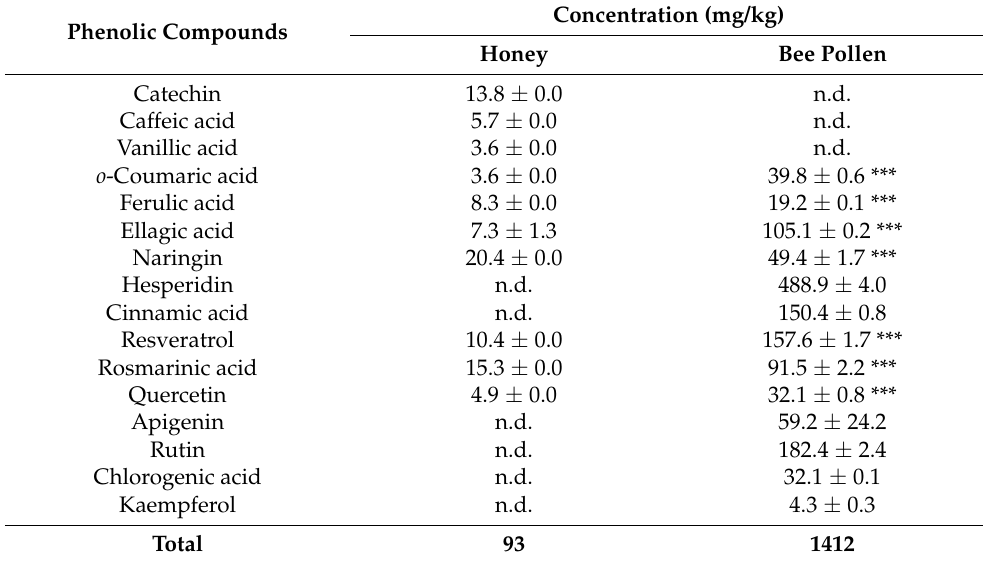
Table 7. Phenolic compound identification and quantification of bee pollen and